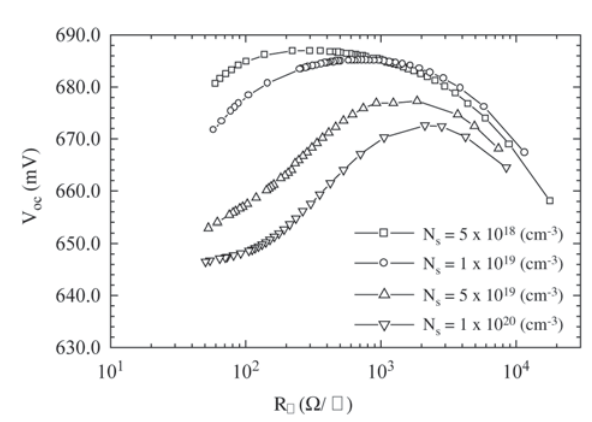
Figure 7. Open circuit voltage, V resistivity, R and surface doping level, N (cid:0) ter solar cells.